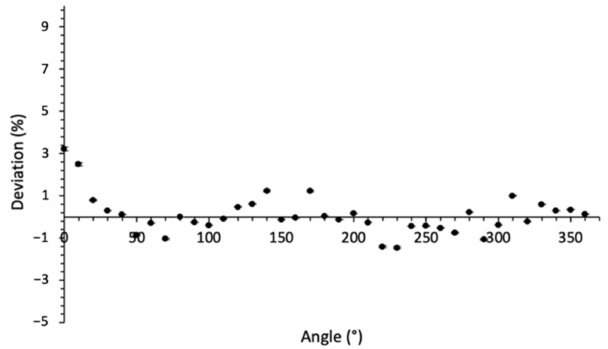
Figure 9. Deviation in % of the dose measured with a PSF from the average dose over 360 ◦ .